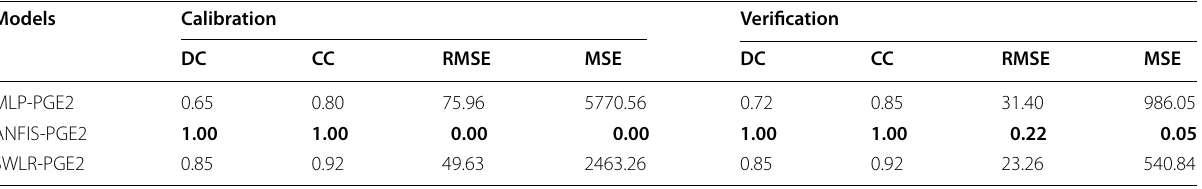
Table 4 Performance of PGE2inflammatory biomarker